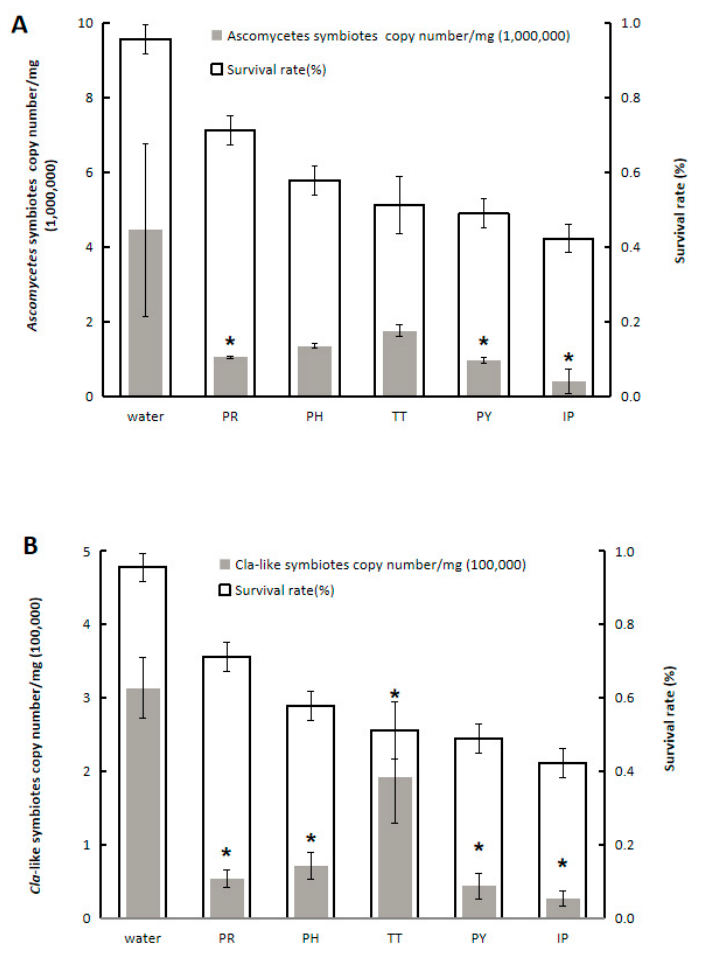
Figure 2. E ff ect of fungicides on the abundance of Ascomycetes symbiotes ( A ) and Cla -like symbiotes ( B ), and on survival rate of female adult WBPH. The abundance of Ascomycetes symbiotes and Cla -like symbiotes was determined by qPCR. On the X-axis PR, 70% propineb wettable powder (WP); PH, 70% propamocarb hydrochloride aqueous solution (AS); TT, 25% trifloxystrobin and 50% tebuconazole water-dispersible granules (WG); PY, 40% pyrimethanil suspension concentrate (SC); IP, 50% iprodione SC; The asterisks represents the significant di ff erences ( < 0.01) which was tested by Tukey’s